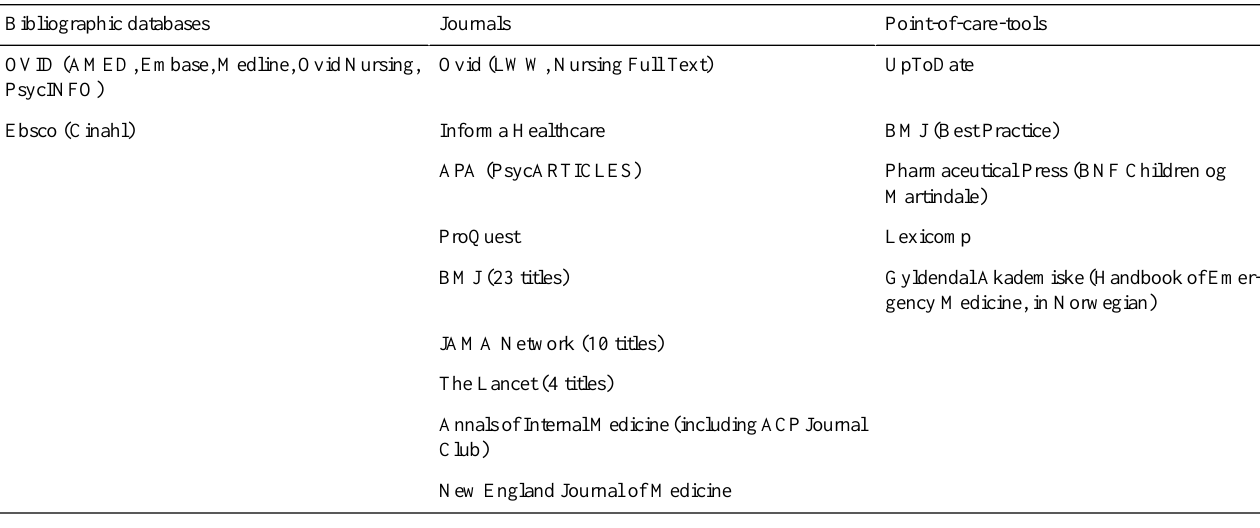
Table 1. Suppliers. Point-of-care-toolsJournalsBibliographic databases